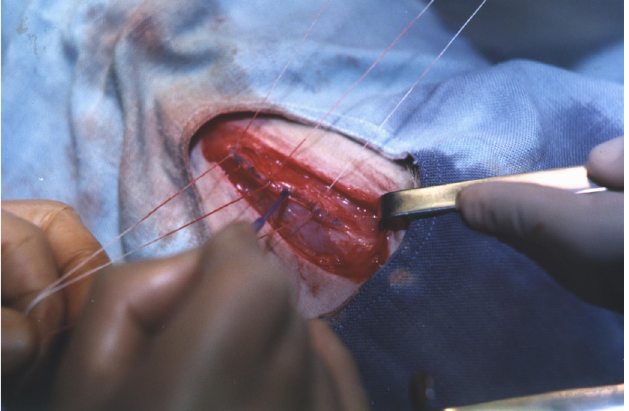
FIGURE 3 – Closure of the aponeurosis using the tissue adhesive